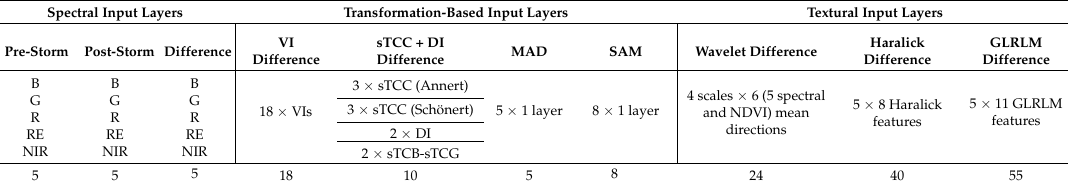
Table 5. Summary of the 175 available input layers at pixel level, distinguishing between spectral, transformation-based, and textural input layers (more details are given in Appendix A). Abbreviations: VI (Vegetation Indices), MAD (Multivariate Alteration Detection), SAM (Spectral Angel Mapper), sTCC (specified Tasseled Cap Coefficients), DI (Disturbance Index), NDVI (Normalized Difference Vegetation Index), GLRLM (Grey-Level Run-Length Martrix). SpectralInputLayers Transformation-BasedInputLayers TexturalInputLayers Pre-Storm Post-Storm Difference VI Difference sTCC+DI Difference